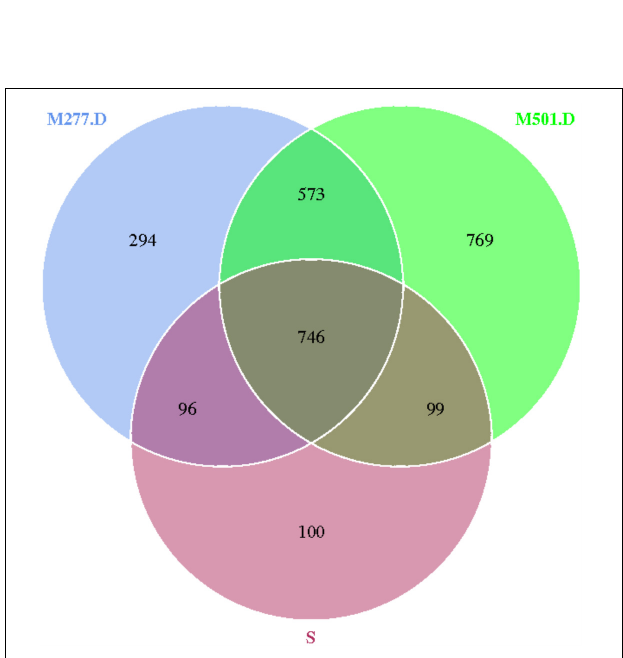
FIGURE 6 | Wayne plot of microbial OTU in soil